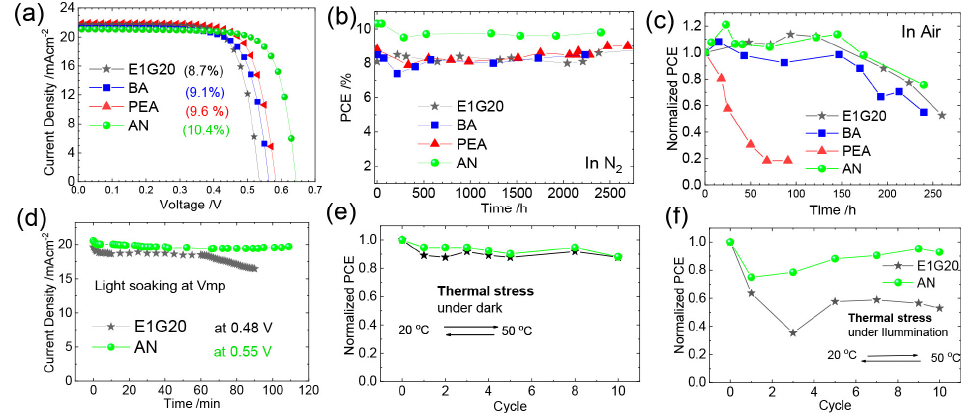
Figure 15. ( a )The 3D/quasi-2D Sn-PVK layer J-V curve, ( b ) Stability under N 2 ambient, ( c ) Air stability ( d ) MPPT test, ( e ) Thermal stress test, ( f ) Thermal stress test under illumination. Reproduced with permission under CC BY-NC-ND 4.0 [80]. Copyright 2021, American Chemical Society.